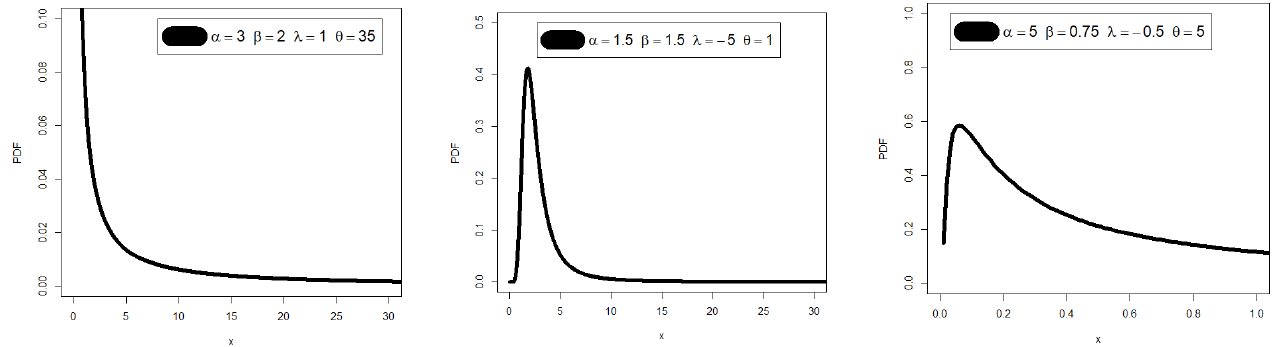
Figure 1. Graphs of the EGRRP PDF for selected parameter values.